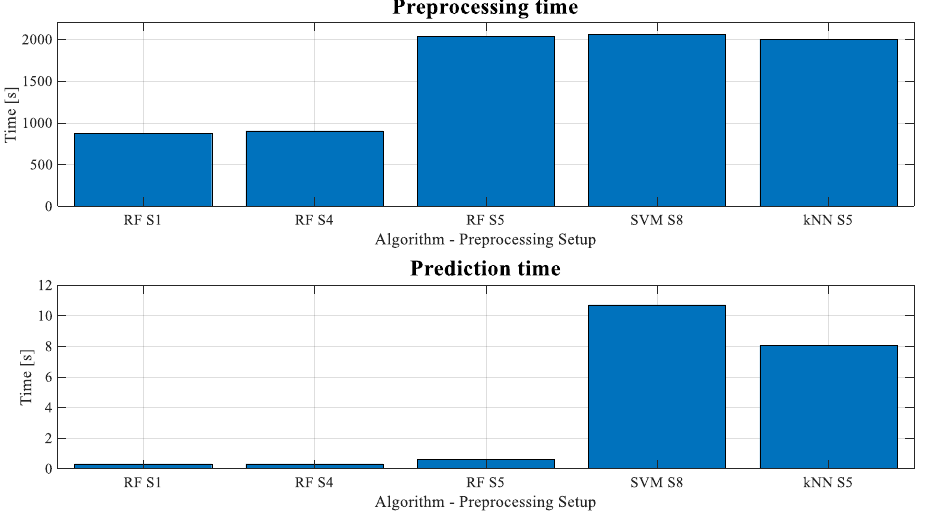
Figure 11. Pre-processing and classification times of the different setups.